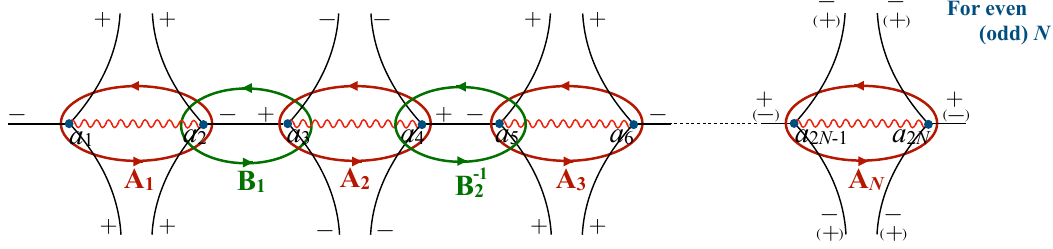
Figure 11 . The Stokes graph for the N ple-well potential for Arg( ~ ) = 0. Perturbative cycles A n and nonperturbative cycles B n are defined as cycles enclosing a branch-cut and a stokes line having end points at turning points,